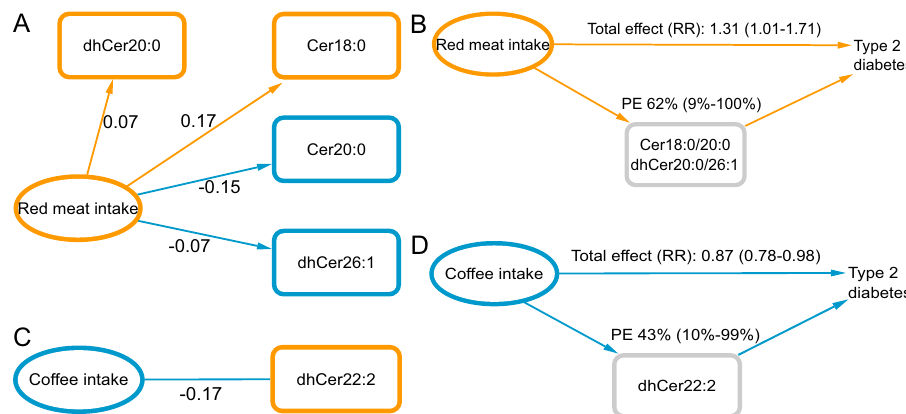
Fig. 3 Mediation analysis. A Adjusted effect estimates (beta coef fi cients) of red meat on T2D-related (dh)ceramides (direction of associations consistent with mediation hypothesis; p -values < 0.05, one-sided t -test). B Attenuation of the putative effect of red meat on T2D risk after adjustment for red meat- and T2D-related (dh)ceramides. C Adjusted effect estimate (beta coef fi cient) of coffee on T2D-related dhCer22:2 (direction of the association consistent with the mediation hypothesis; p -value < 0.05, one-sided t -test). D Attenuation of the putative effect of coffee on T2D risk after adjustment for coffee- and T2D-related dhCer22:2. All models were extensively adjusted for potential confounders (age, sex, fasting status, total energy intake, leisure-time physical activity, medication, smoking, alcohol consumption, and education). Blue indicates inverse association (i.e., lower ceramide concentration or T2D risk), orange: positive association (i.e., higher ceramide concentration or T2D risk). Total effect is the confounder-adjusted hazard ratio (95% CI) per exposure unit: red meat, 2 SD (~1 portion per day); coffee, two cups (300 mL) per day. PE Proportion explainable, i.e., relative attenuation of the total effect through mediator-adjustment. Cer ceramide, dhCer dihydroceramide.